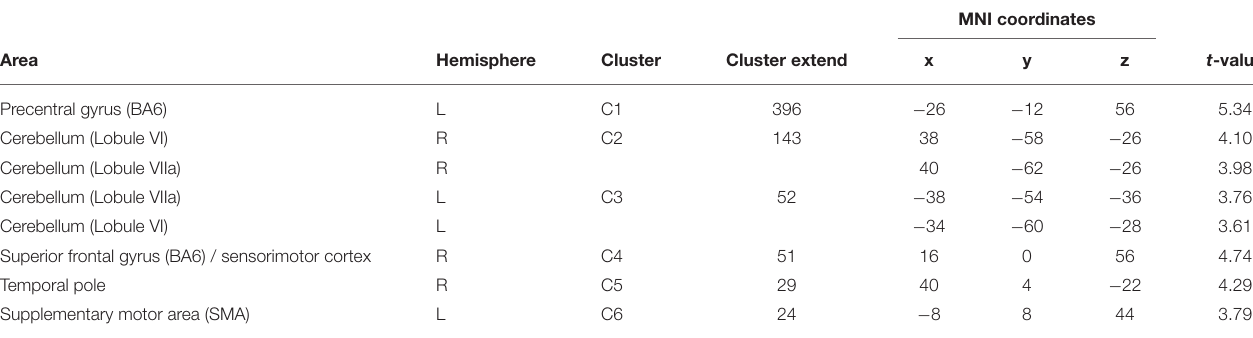
TABLE 4 | Conjunction analysis of interaction and main effect of positive auditory during neutral olfactory stimulation (A × O ∩ A + O 0